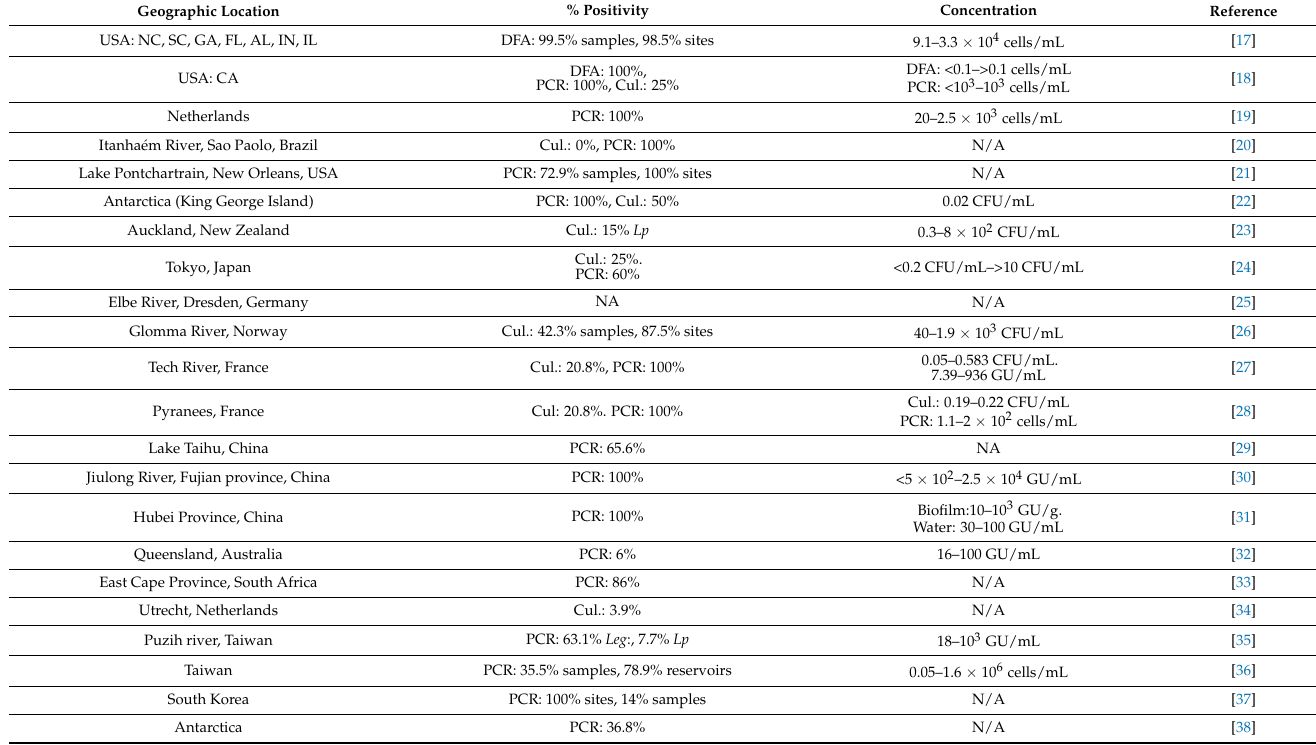
Table 1. Occurrence of Legionella in Surface